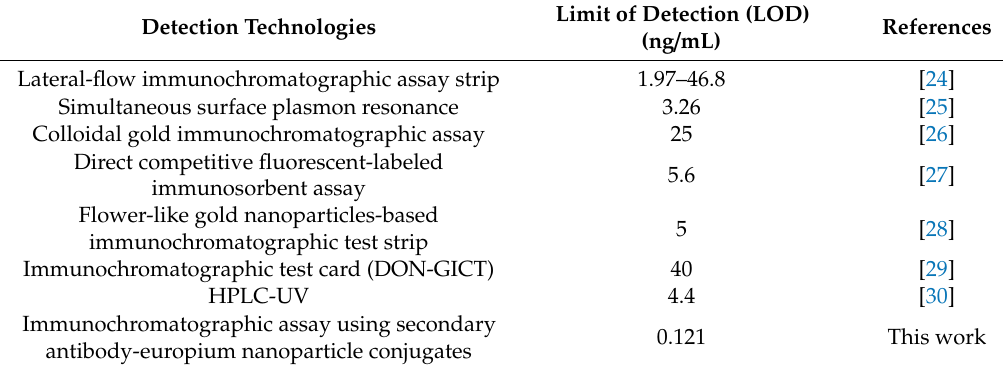
Table 1. Comparison of the present study with existing detection technologies.